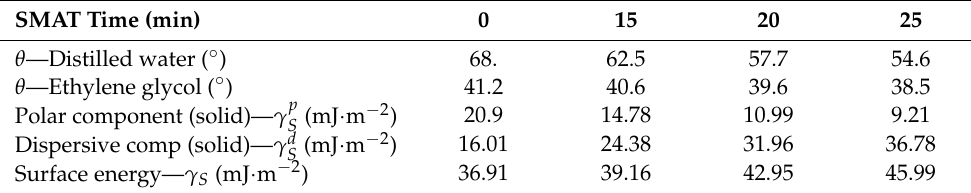
Table 2. Surface energy calculation based upon angle θ and SMAT time.